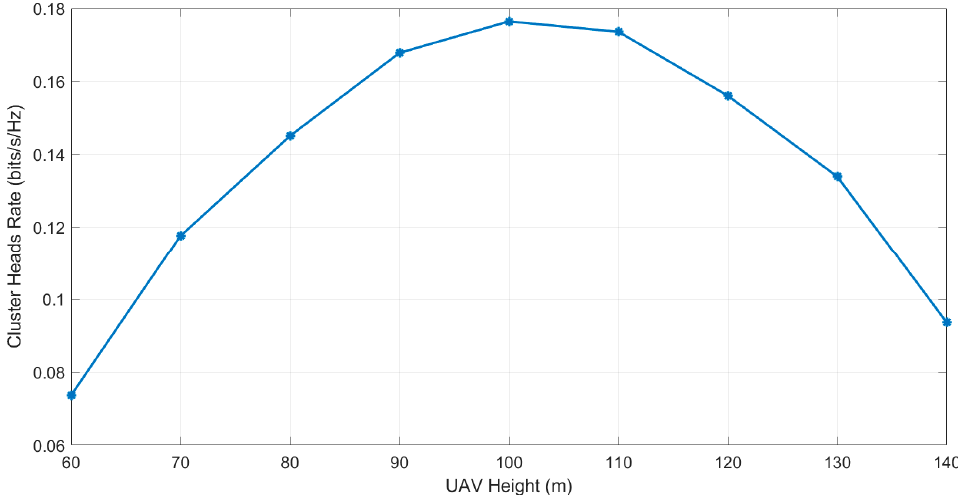
Figure 8. Variation in the cluster heads average rate as the UAV height changes.